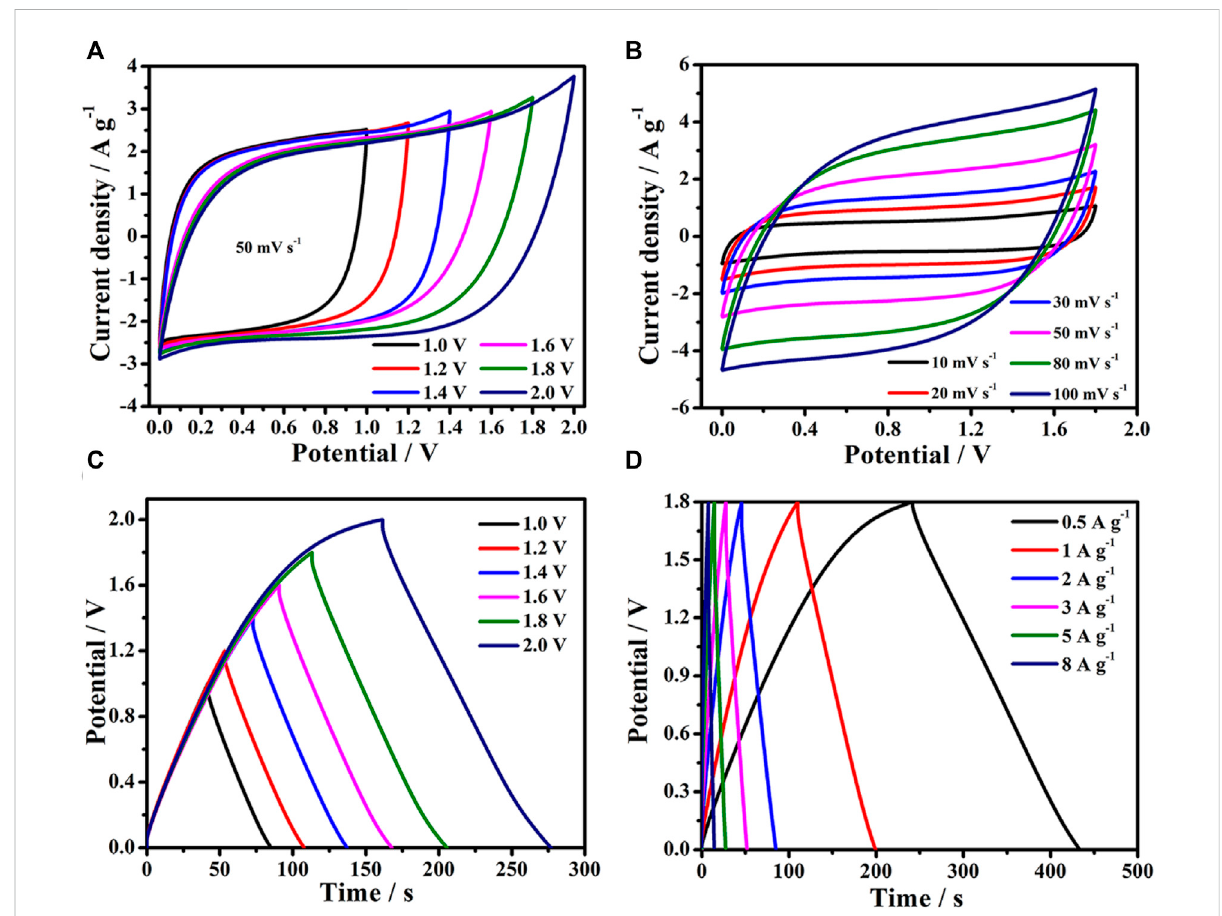
FIGURE 6 (A) CVcurvesoftheAWC-K//AWC-Kdeviceat50 mV s − 1 withvariousvoltage; (B) CVcurvesofthetwo-electrodecellatdifferentscanrates; (C) GCD curves of the two-electrode cell at different current densities; (D) The GCD curves of the two-electrode cell at 1 A g − 1